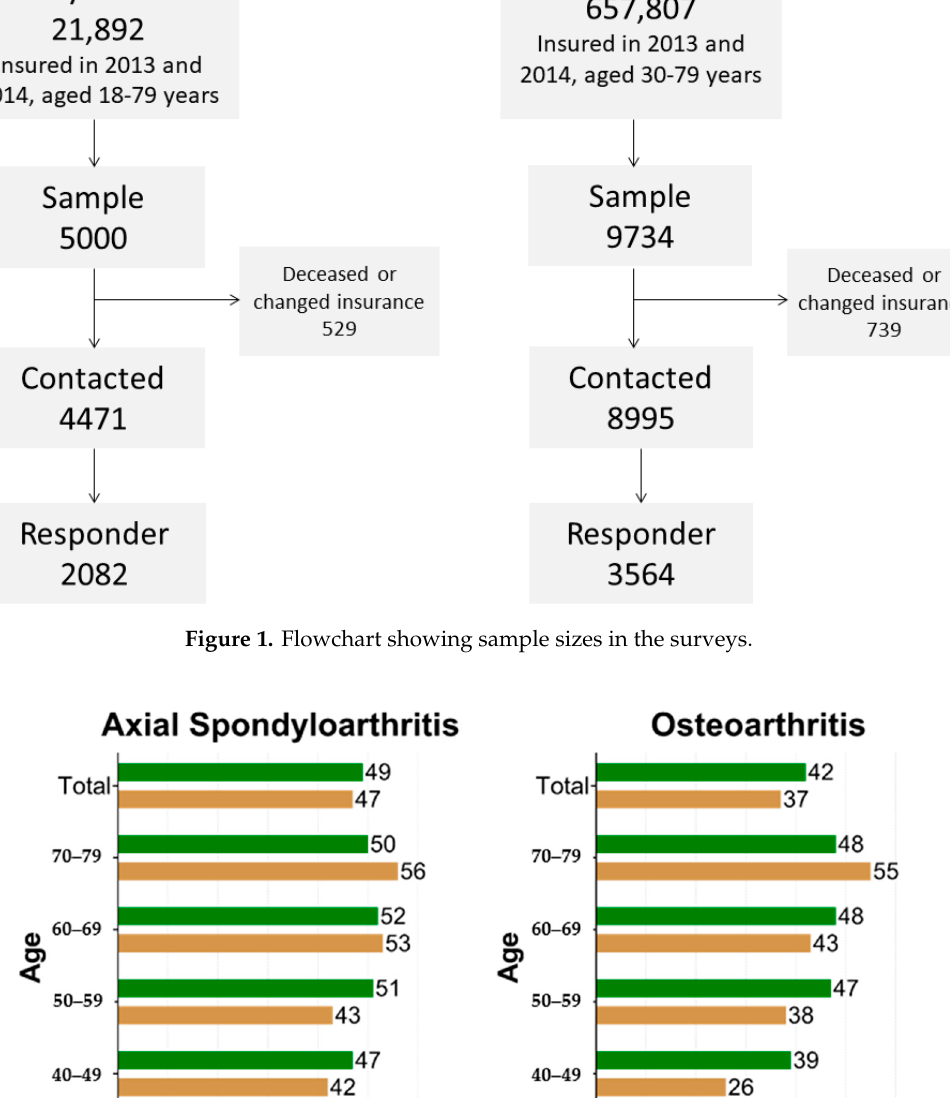
Figure 2. Response in percent by age stratum and sex for both samples.